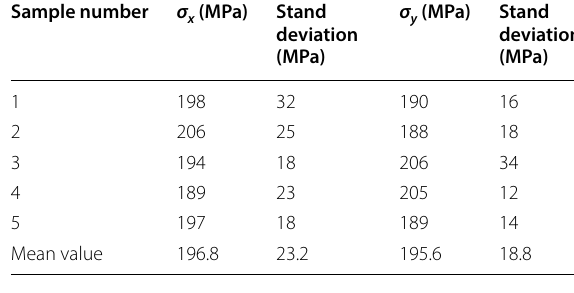
Figure 3 Sample milling setup